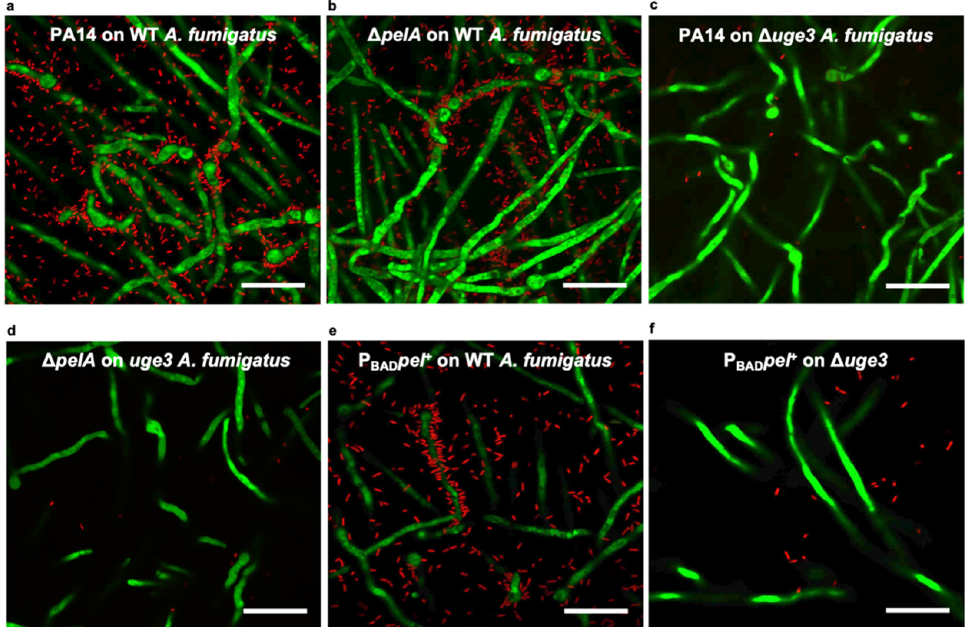
Figure 2. GAG but not Pel is required for the adherence of P. aeruginosa to A. fumigatus . Confocal microscopy images of green fluorescent protein (GFP)-producing A. fumigatus co-cultured with mCherry-producing P. aeruginosa . ( a ) Wild-type P. aeruginosa (PA14) adherent to hyphae of wild-type (WT) A. fumigatus . ( b ) Pel-deficient P. aeruginosa ( Δ pelA ) adherent to hyphae of WT A. fumiga-